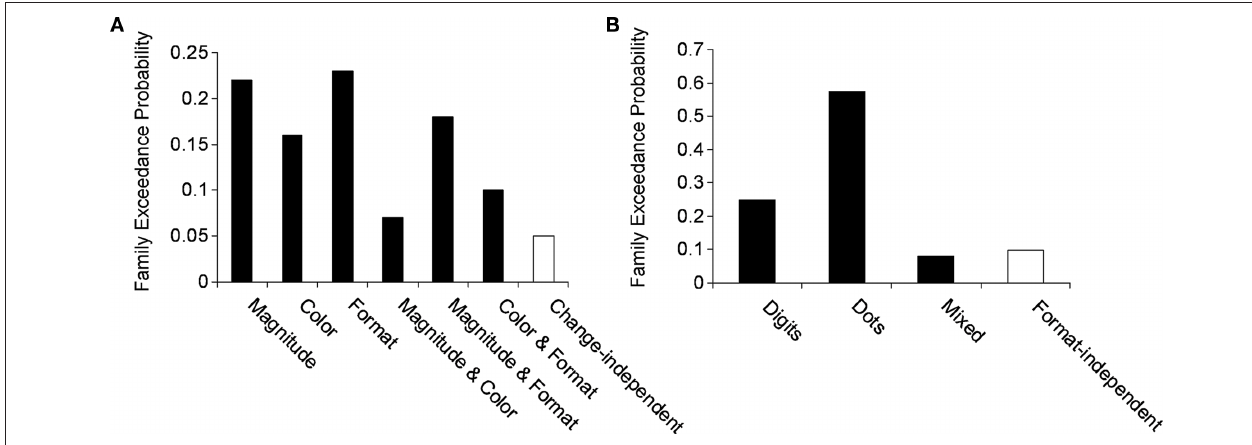
change-dependent and format-dependent families. In line with Penny et al. (2010) we grouped the families which shared a feature of interest, in this case extrinsic-dependent modulation. The aggregated evidence for these families has yielded exceedance probabilities above 0.9 for